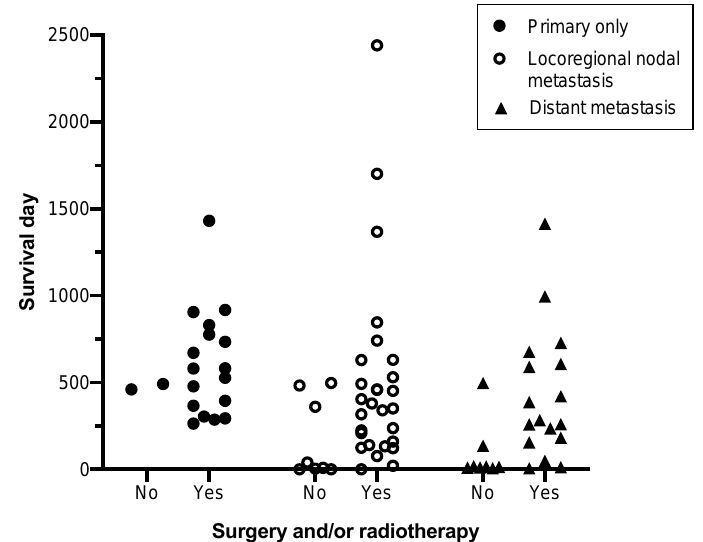
Figure 2. AGASAC patients that underwent aggressive locoregional therapy with surgery and/or radiotherapy had improved survival times compared to patients receiving no treatment or chemotherapy alone. Survival times are grouped by treatment received, and are stratified by clinical stage. Table 3. Median survival times of dogs with AGASAC stratified by clinical stage and treatment. Clinical Stage